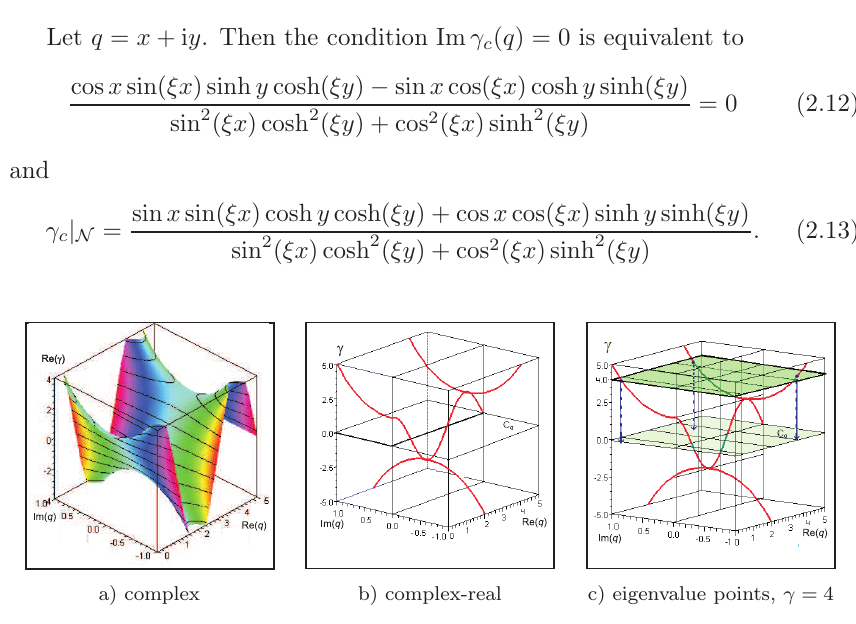
Figure 5. Characteristic functions for ξ = 1 / 2 in C q .